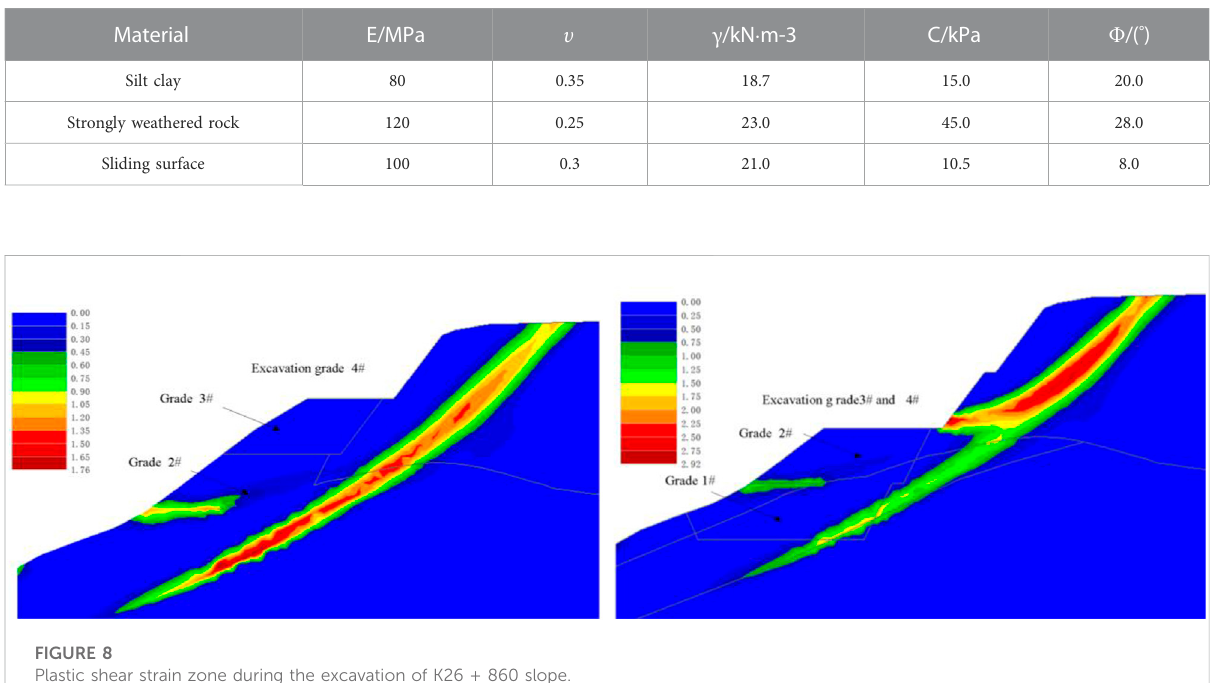
Plastic shear strain zone during the excavation of K26 + 860 slope.